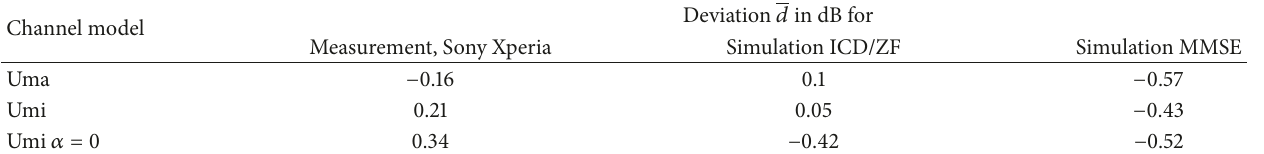
Table 3: Comparison of the deviation 𝑑 between measurement and simulations. Deviation 𝑑 in dB for Channel model Measurement, Sony Xperia Simulation ICD/ZF Simulation MMSE Uma − 0.16 Umi 0.21 Umi 𝛼 = 0